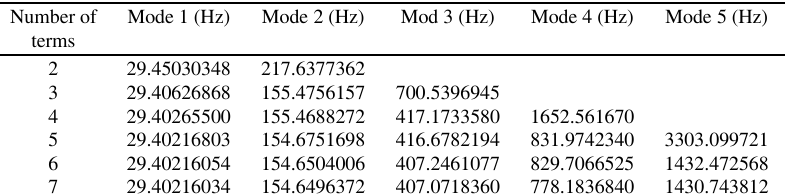
Table 10 Convergence of natural frequencies as a function of number of terms in the polynomial shape